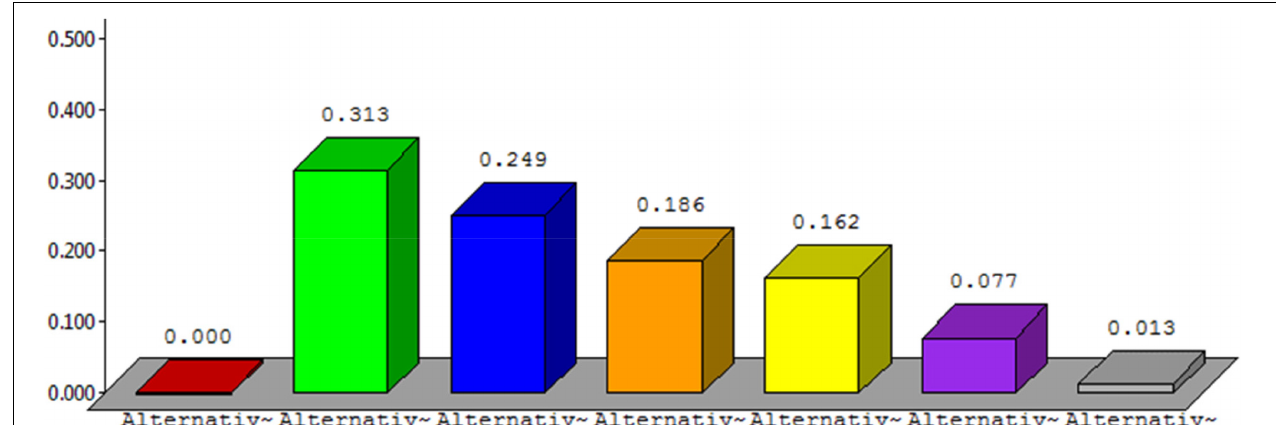
FIGURE 6 | Alternative